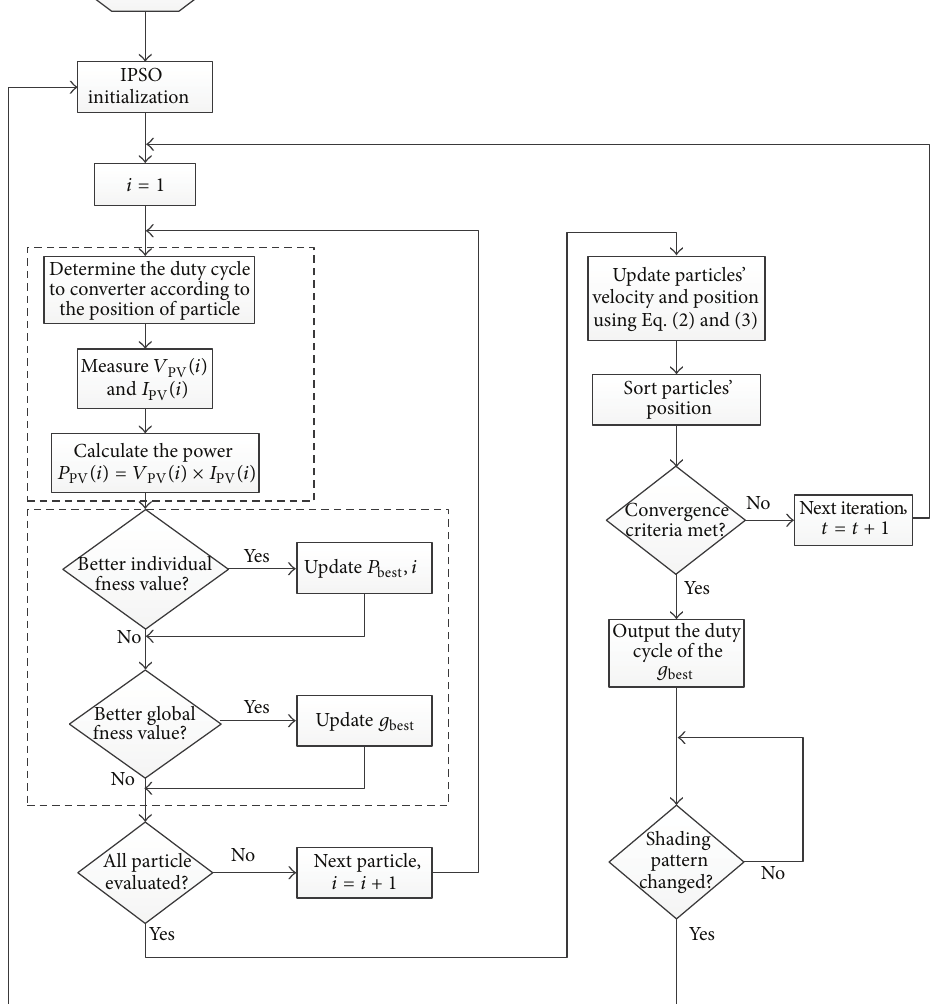
Figure 4: Flowchart of the proposed IPSO-based MPPT